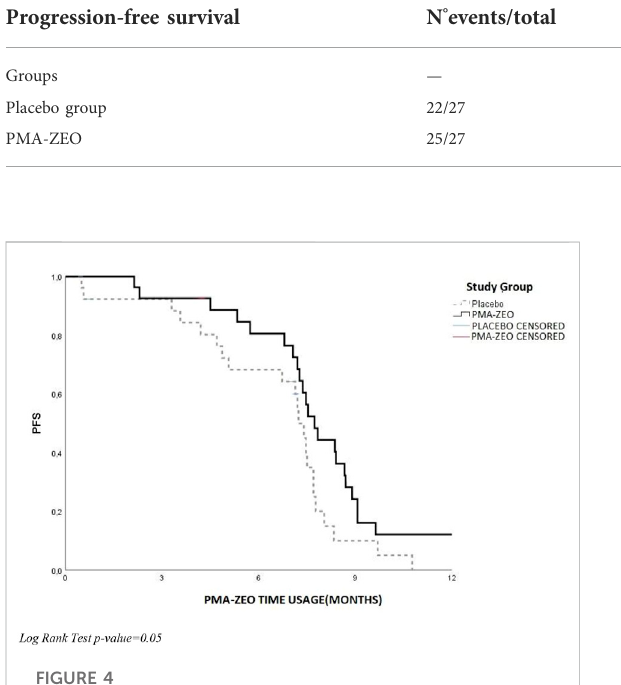
FIGURE 4 Progression-free survival (PFS) at the PMA-ZEO 7-month time point for cancer relapse strati fi ed by I ° line treatment group.